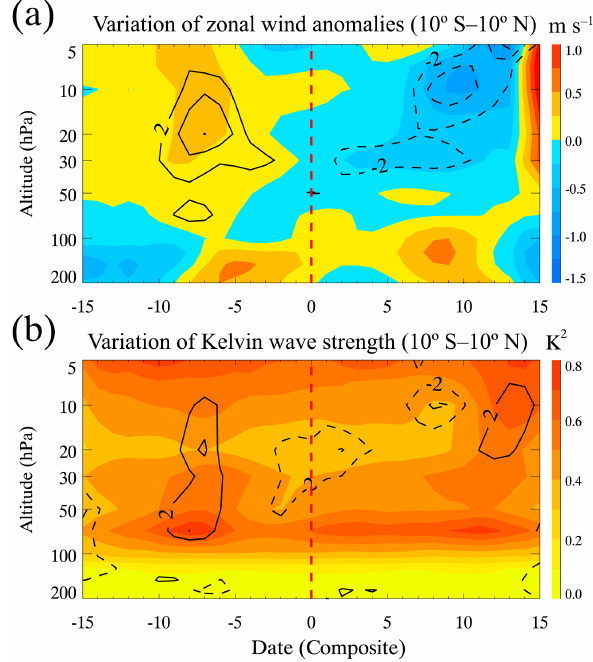
Figure 7. The time–altitude cross section of (a) the anomalous zonal mean zonal wind averaged between 10 ◦ S and 10 ◦ N, and (b) the strength of Kelvin waves averaged between 10 ◦ S and 10 ◦ N. The red vertical lines indicate day 0 of the composite event. All of the variables above are presented both in physical value (color shades) and t values (black contours). Solid contours indicate pos- itive t values of anomalous values while dashed contours indicate negative t